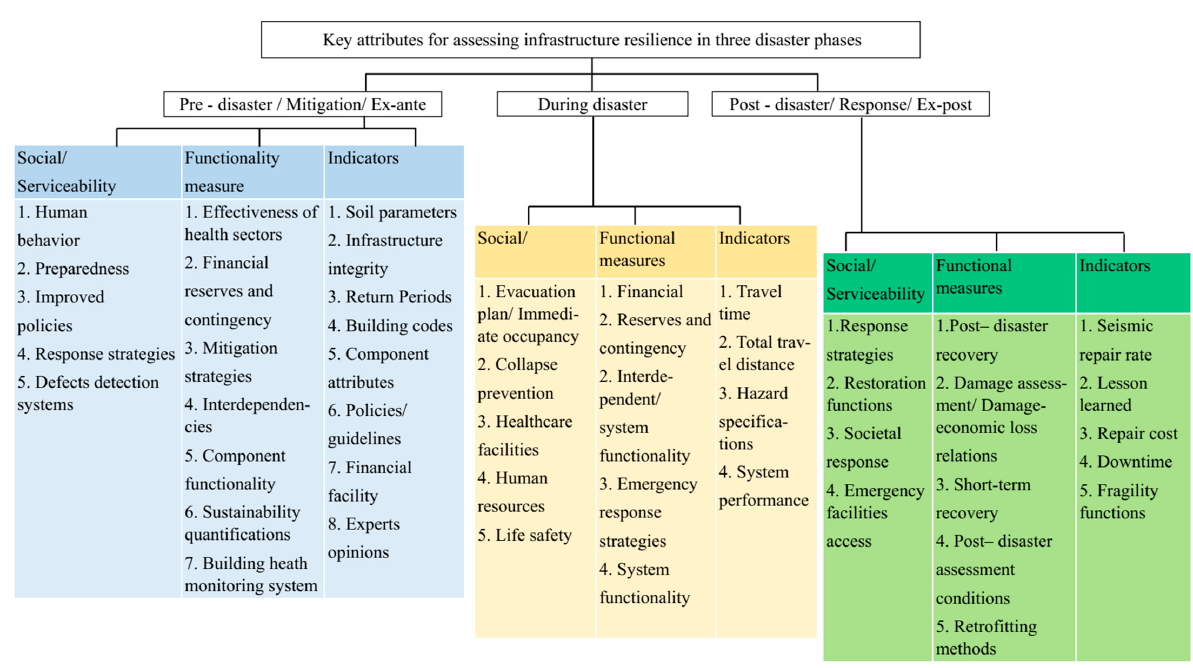
Figure 11. Key features for assessing infrastructure resilience in different phases of a disaster (pre-, during, and post-disaster) to develop an integrated and adaptable framework.